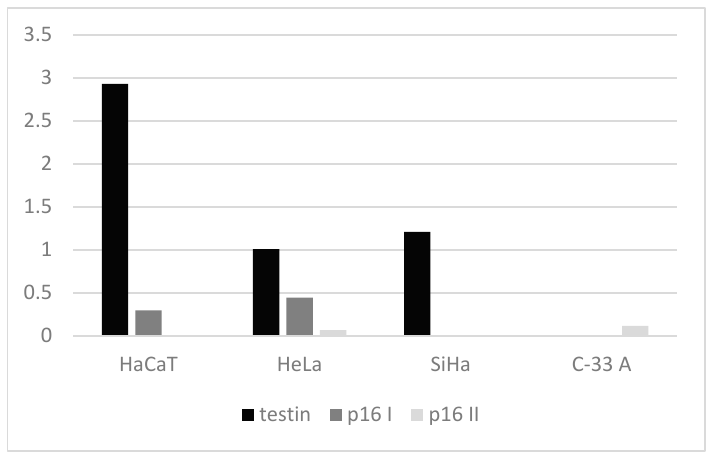
Figure 5. WB: testin and p16 expression in HaCat, HeLa, SiHa and C-33 A cell lines.